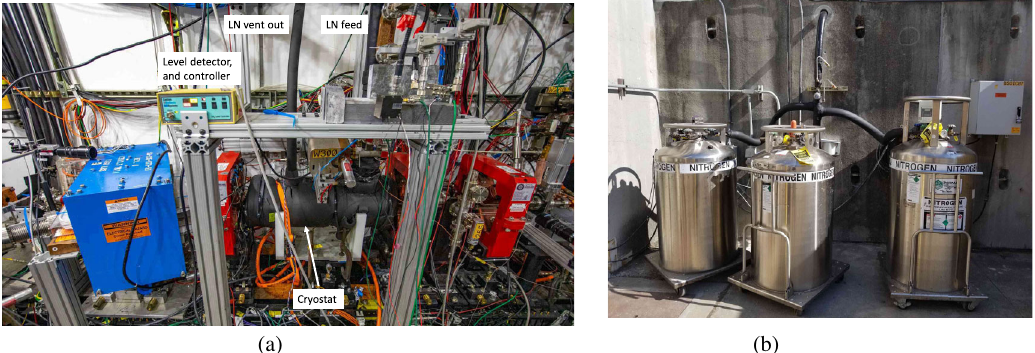
FIG. 5. (a) A picture of the installed cryostat in the XTA beam line and (b) the LN feeding system outside the